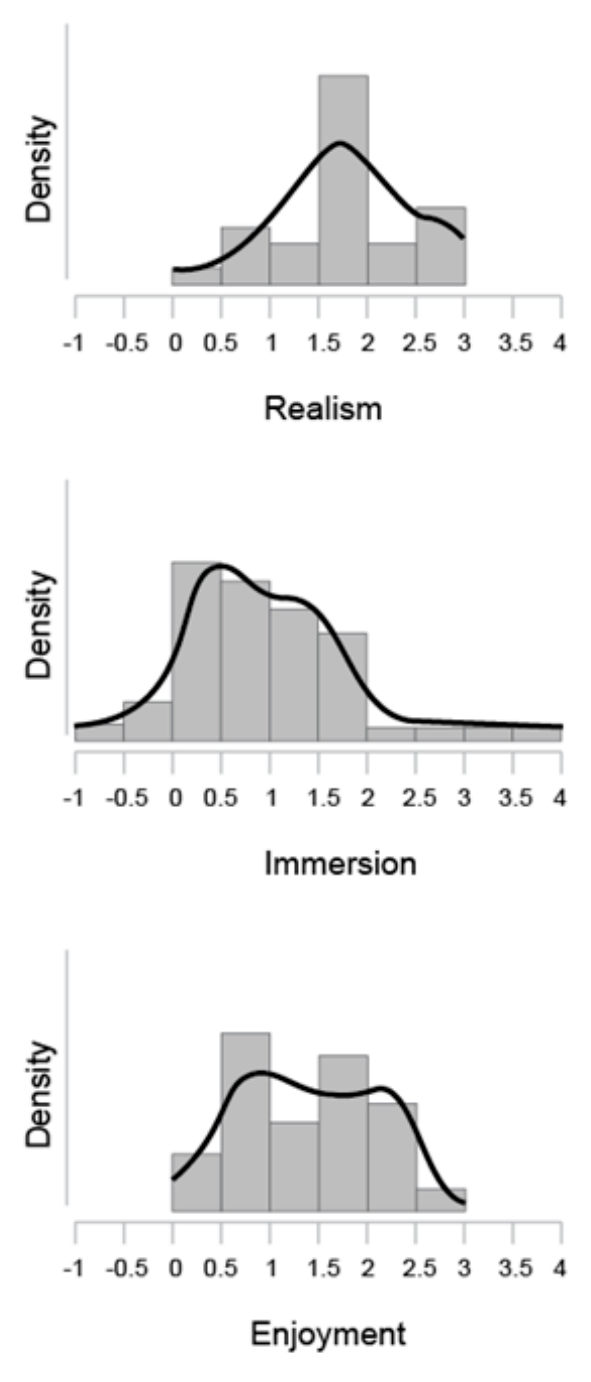
Figure 9. Densities according to the Likert-scale score differences for realism, immersion, and en-